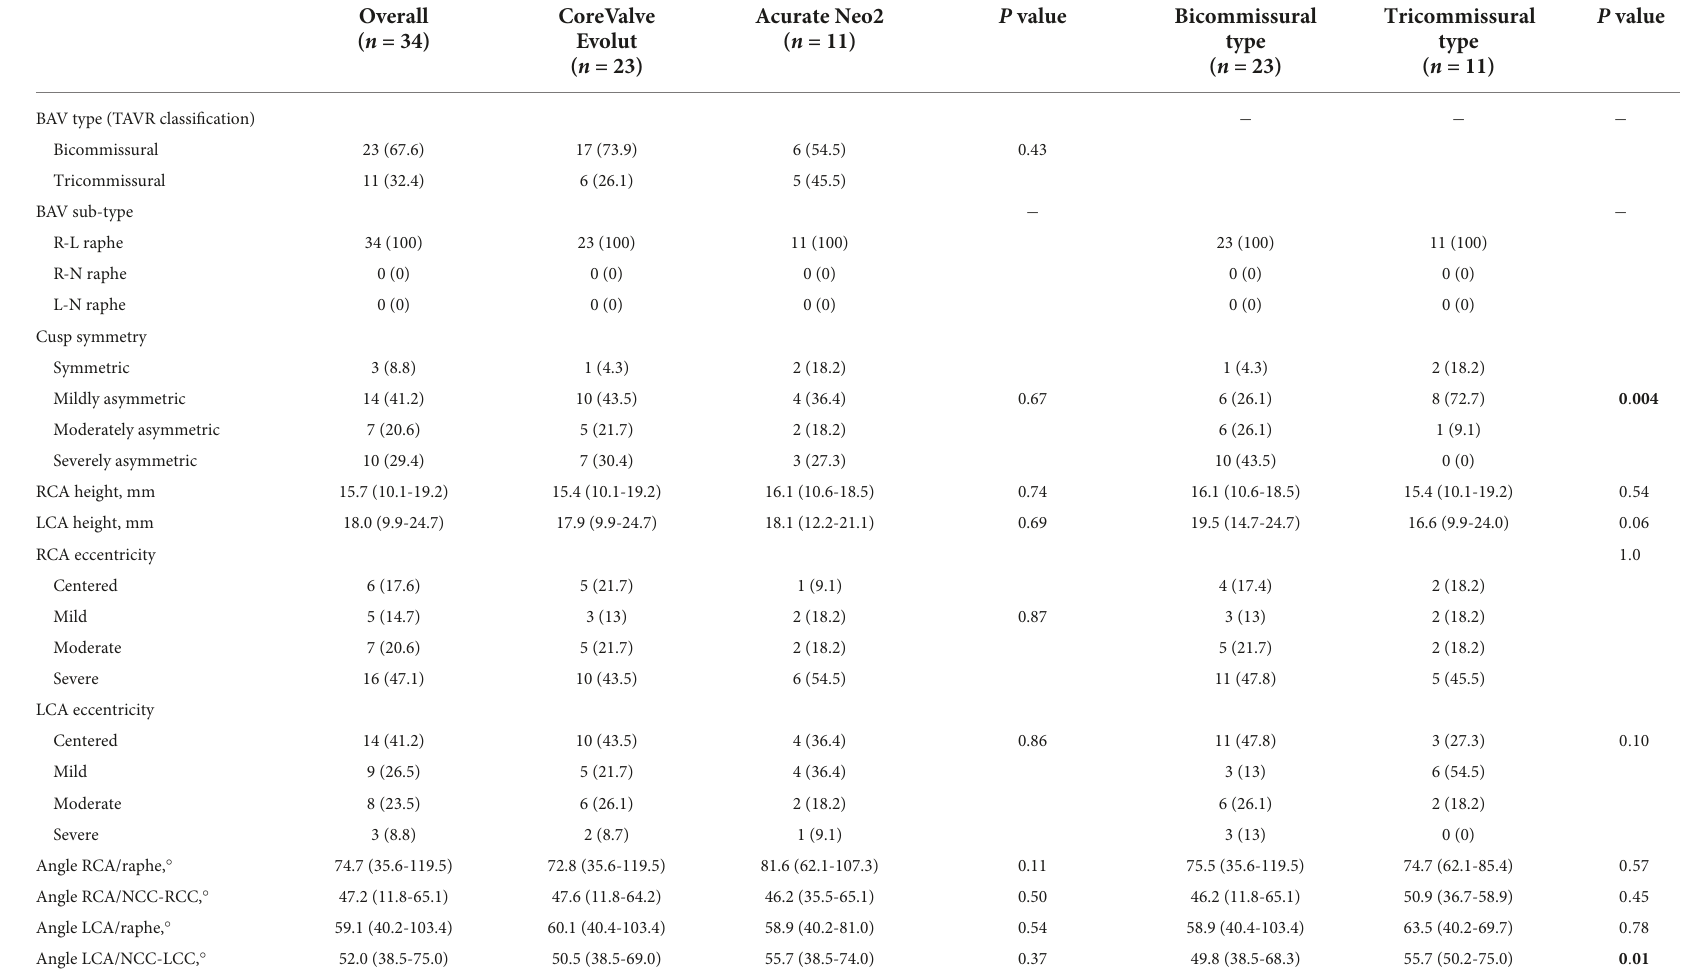
TABLE 2 Pre-procedural CT analysis – Overall study